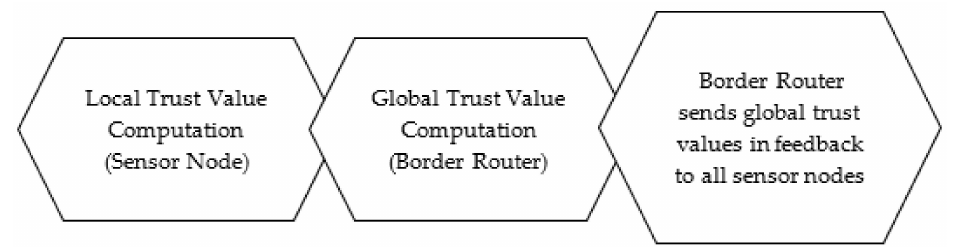
Figure 7. E7-Cooperative feedback trust values for energy-efficient routing